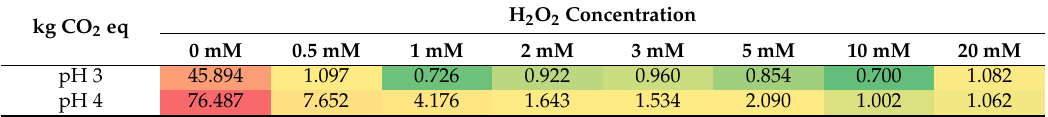
Table 4. Comparison of the CCP (kg CO 2 eq) degradation processes results at di ff erent H 2 O 2 concentrations in the presence of Fe 3 O 4 / HA (100 mg / L) as a catalyst, performed at pH levels 3 and 4.